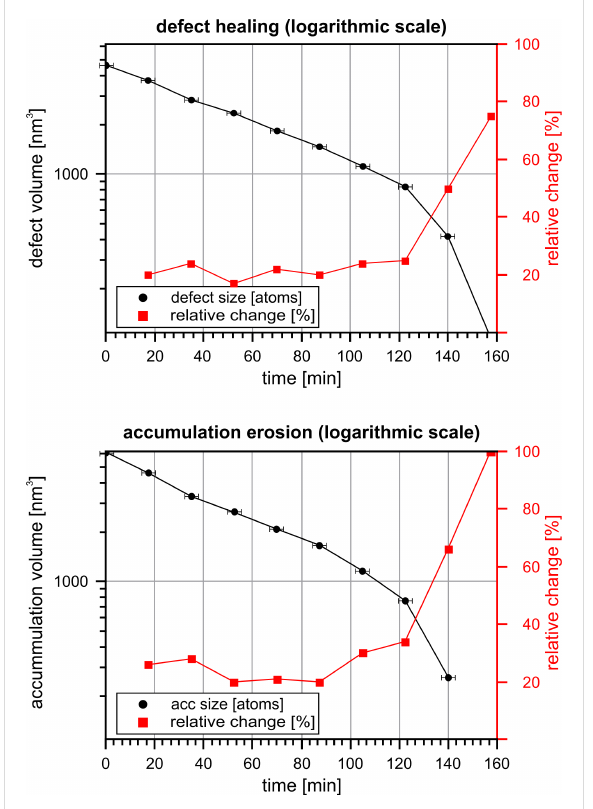
Figure 9: Time course of the size and change rate of the observed defect (upper position) and accumulation (lower position) at RH = 28.2%. For larger structures the total size shows an (approxi- mately) linear decrease on a logarithmic scale. The relative change de- scribes the ratio between the transported material and the previous structure volume per each timestep of 1050 s. For larger structures this value stays roughly